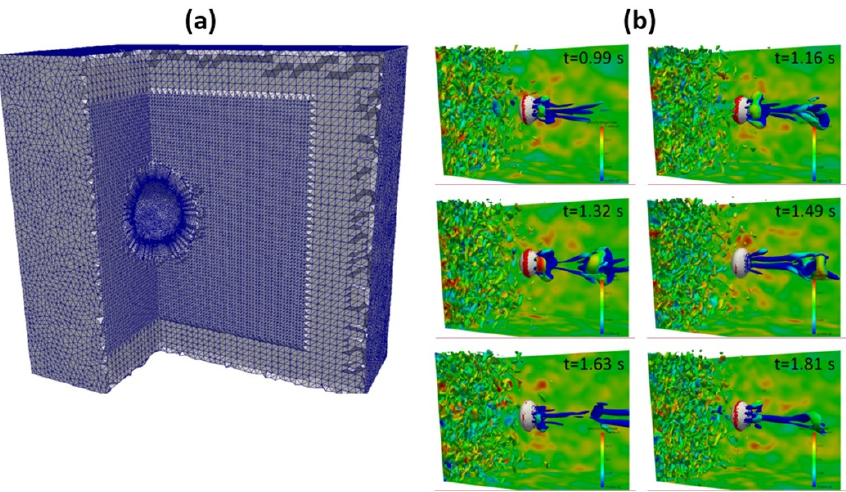
Figure 6. ( a ) Mesh used in the BIT study, ( b ) turbulent eddy generated on the highly deformable bubble surface (Q-criterion with a value of 100) [155].